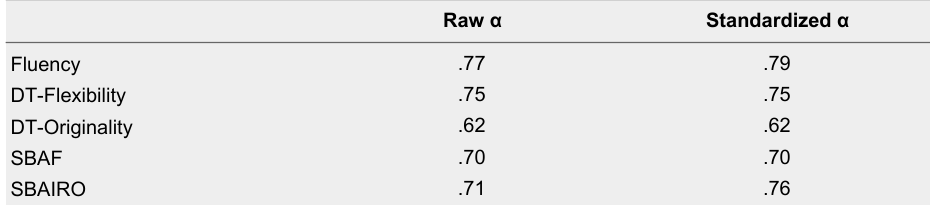
Alpha (α) Inter-item Reliability